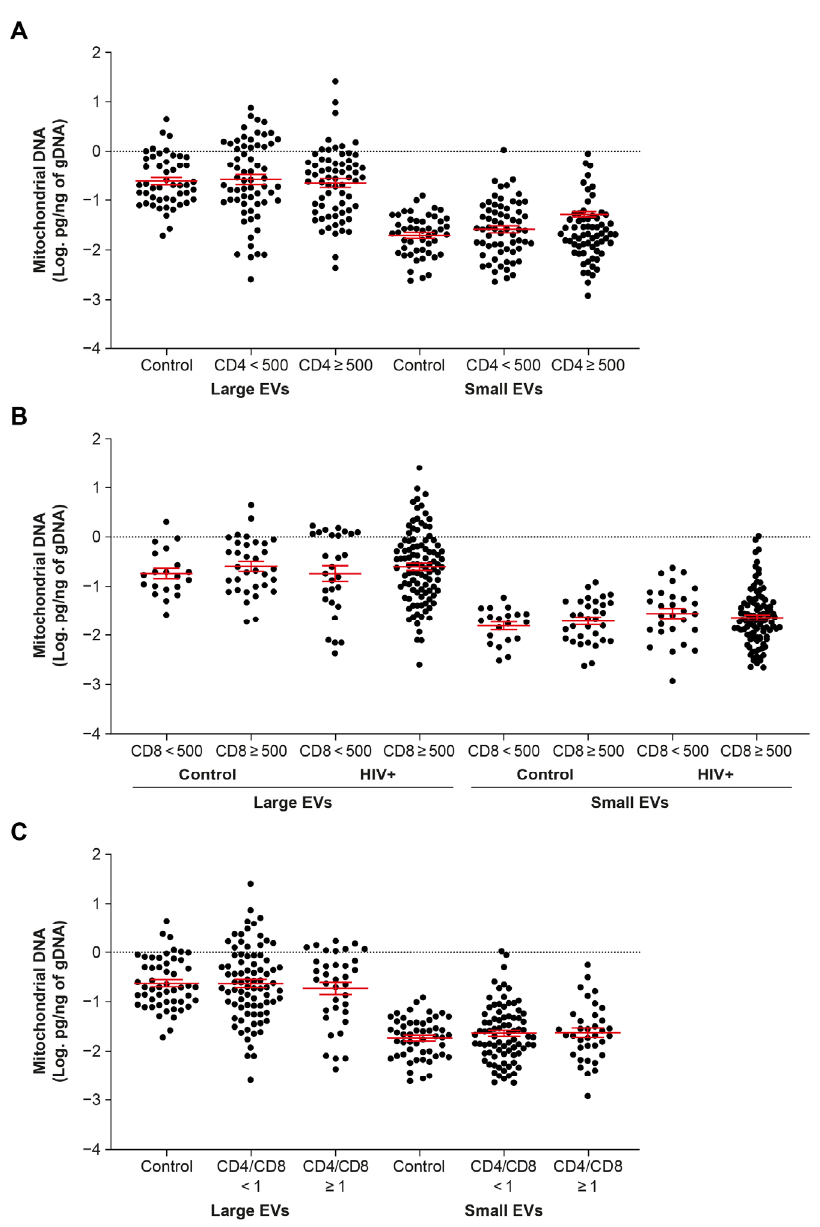
Figure 3. Mitochondrial DNA content of large and small EVs in individuals in different categories of CD4 T cell count ( A ), CD8 T cell count ( B ), and CD4/CD8 ratio ( C ). In graphs, the dots represent individual value and lines the mean with the standard error of the mean. Ordinary one-way ANOVA with Tukey’s multiple comparisons was used to reveal significant differences.